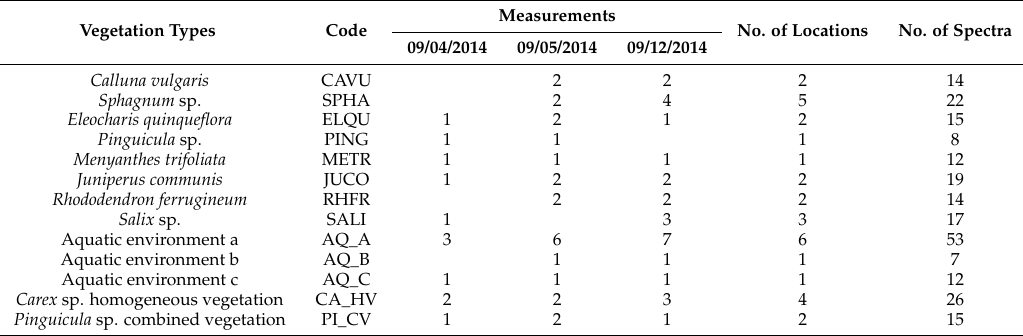
Table 1. Species names, number of measurements, number of locations and total number of spectra collected.